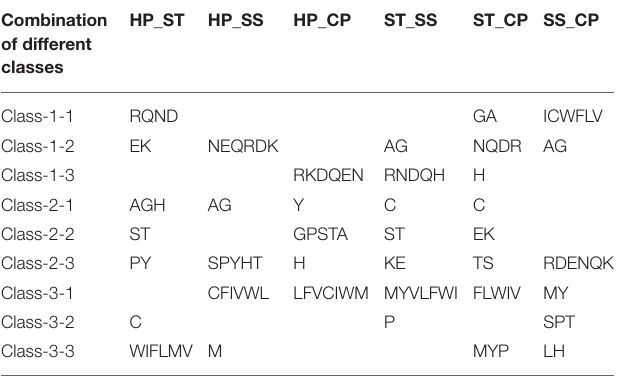
TABLE 2 | RAAAs based on different types of physicochemical properties.